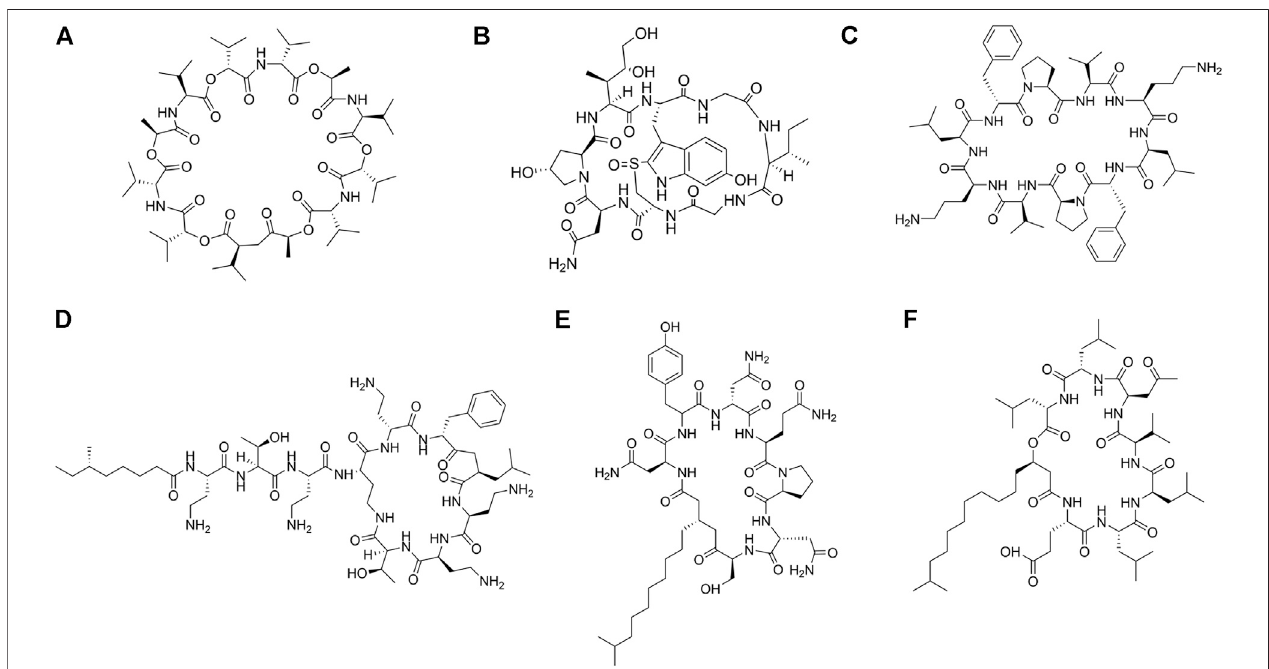
FIGURE 3 | Examples of natural cyclic AMPs. (A) Valinomycin. (B) Alpha-Amanitin. (C) Gramicidin S. (D) Polymyxin B. (E) Iturin A. (F) Surfactin C.